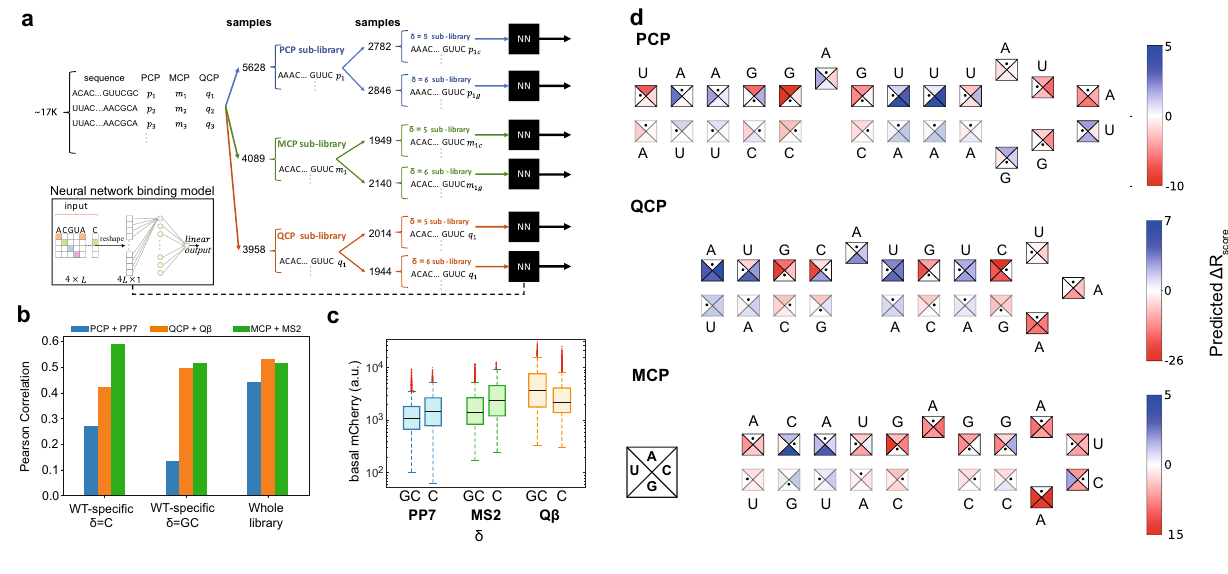
Fig. 3 Analysis of MCP, PCP, and QCP RNA-binding sequence preferences. a Scheme for the data preparation and neural network architecture (inset) used. b Pearson correlation over a held-out test set computed for the WT-speci fi c sub-libraries (i.e., PCP, MCP, and QCP with PP7-based, MS2-based, and Q β -based binding sites, respectively at either δ = C (left) or δ = GC (middle)), and for the whole-library CNN model (right). c Boxplots of basal mCherry levels for the six WT-speci fi c sub-libraries, based on the following number of strains (from left to right): 3113 (PP7-GC), 3067 (PP7-C), 2810 (MS2-GC), 2743 (MS2-C), 2702 (Q β -GC), 2743 (Q β -C). On each box, the central mark indicates the median, and the bottom and top edges of the box indicate the 25th and 75th percentiles, respectively. The value for ‘ Whisker ’ corresponds to approximately ±2.7 STD (standard deviation) and 99.3 percent coverage and extends to the adjacent value, which is the most extreme data value that is not an outlier. The outliers are plotted individually as plus signs. d Illustrations of the whole-library model predictions for the three sub-libraries for any single- or double-nucleotide structure-preserving mutation. Each binding site is shown, with the wild-type sequence indicated as black dots inside the squares. Each square is divided to the four possible options of nucleotide identity, with the colors representing the predicted change in R score with respect to the wild type for each option. Source data are provided as a Source data fi